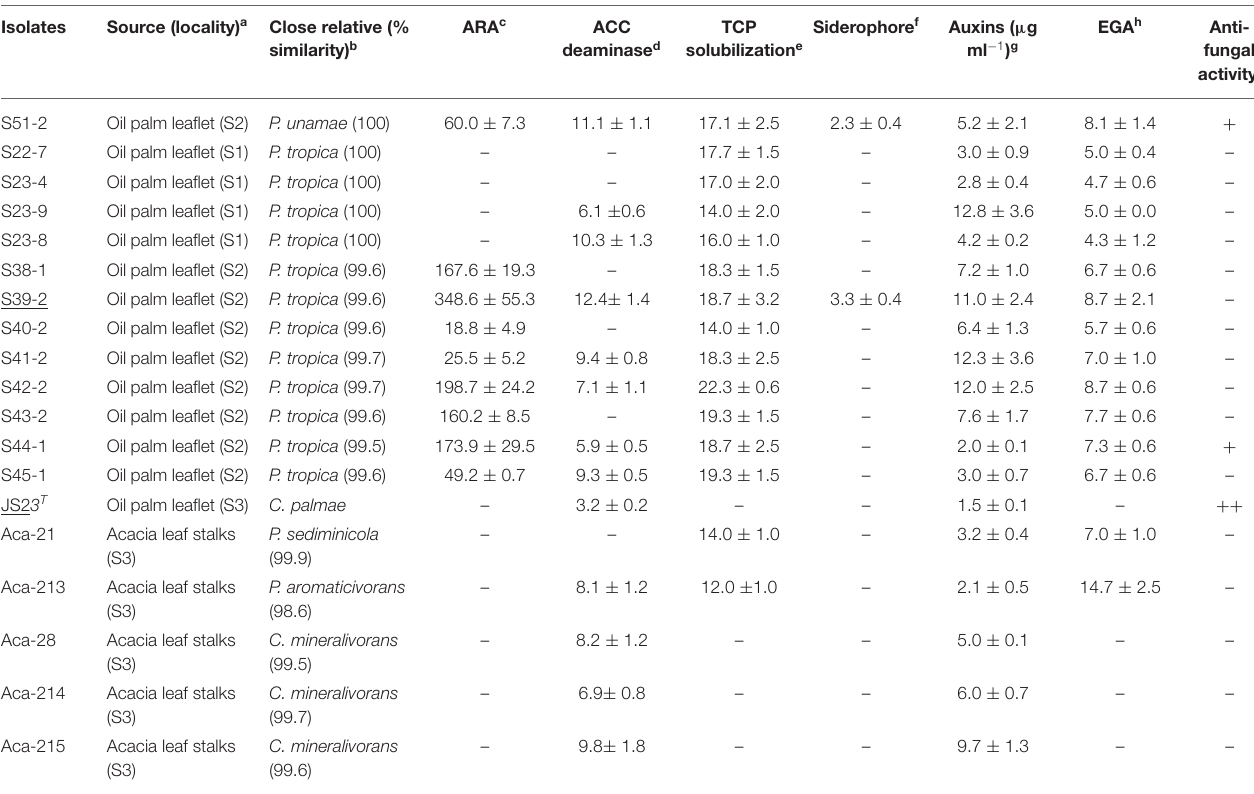
TABLE 1 | Screening for growth-promoting traits of endophytic isolates from oil palm and acacia leaves. Isolates Source (locality) a Close relative (% similarity)